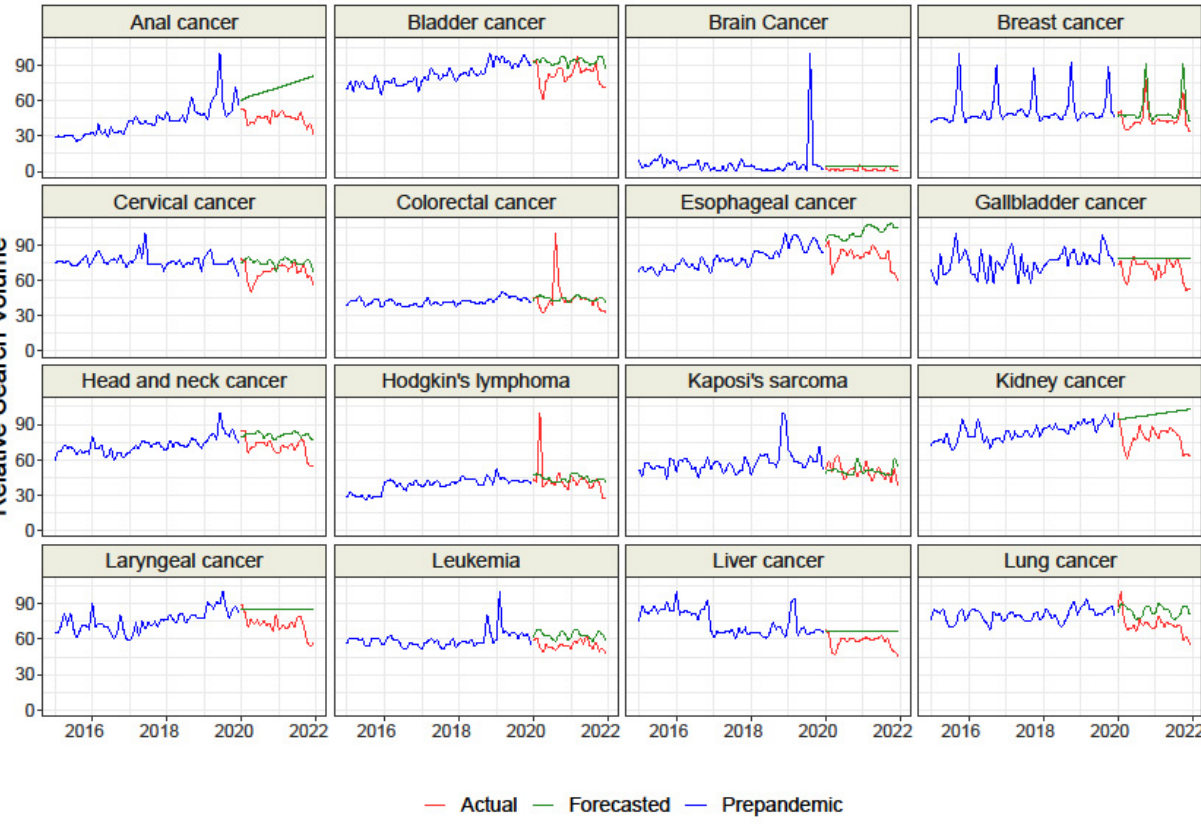
Figure 2. Relative Search Volume of Google queries on chosen malignancies.